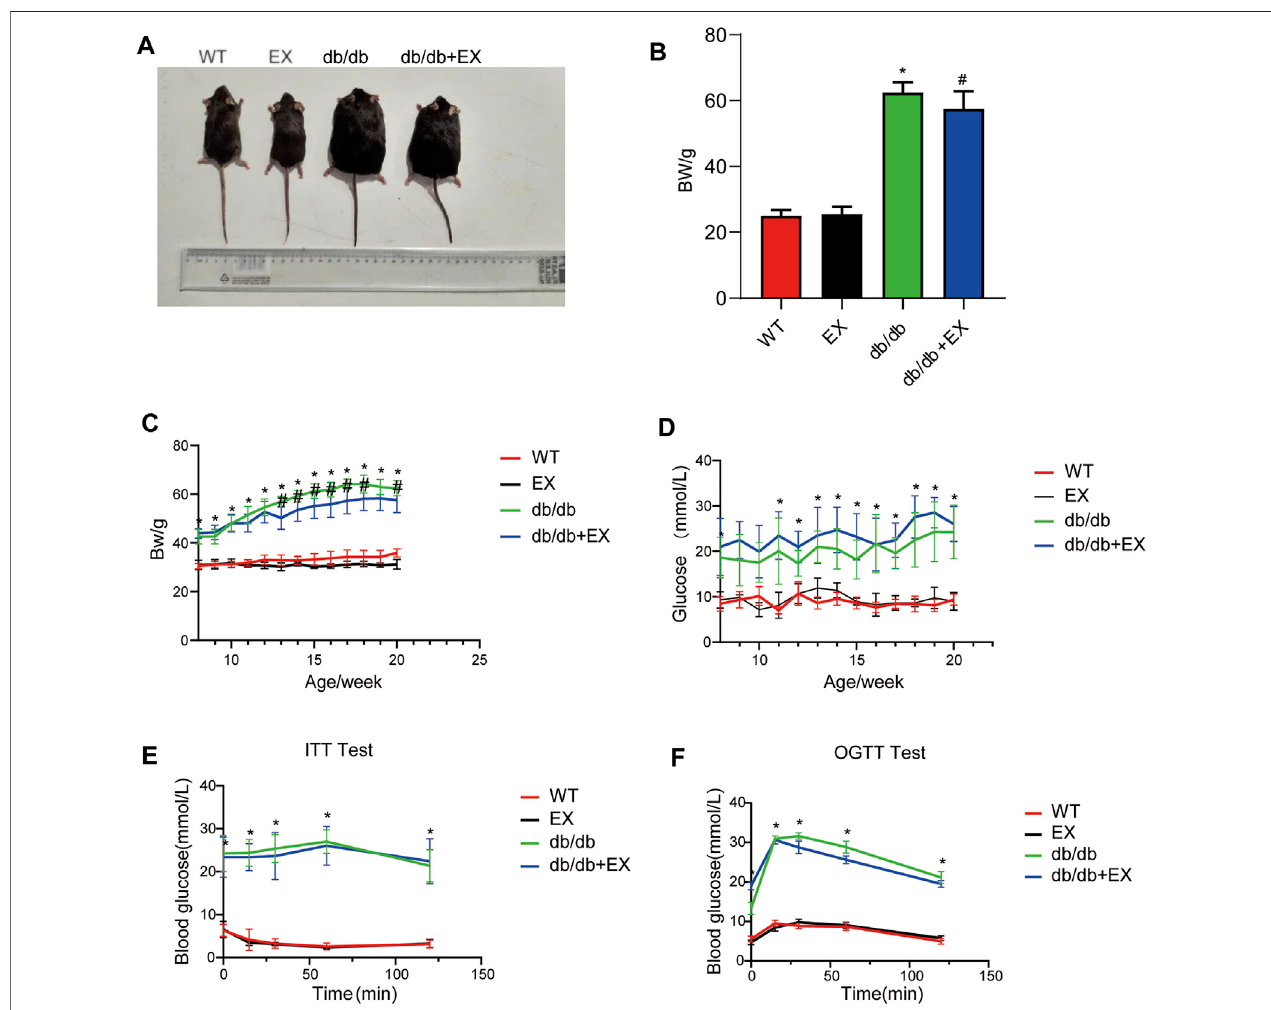
FIGURE 2 | Changes in general characteristics of mice. (A) The appearance of mice after exercise training. (B) Weight of mice after exercise training. (C – F) Body weight and blood glucose level during exercise training in mice. * p < 0.05 vs. the WT group, # p < 0.05 versus the db/db group.